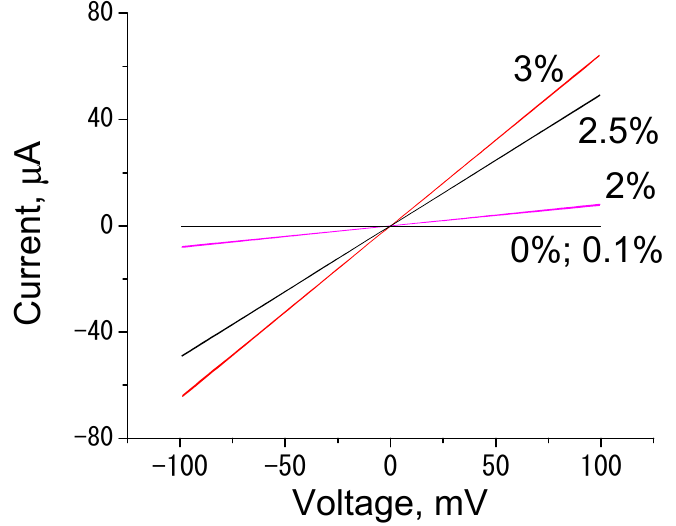
Figure 8. Voltage − current relationships of dry chitosan − based films containing 0, 0.1, 2.0, 2.5, and 3.0 wt.% of SWCNT.